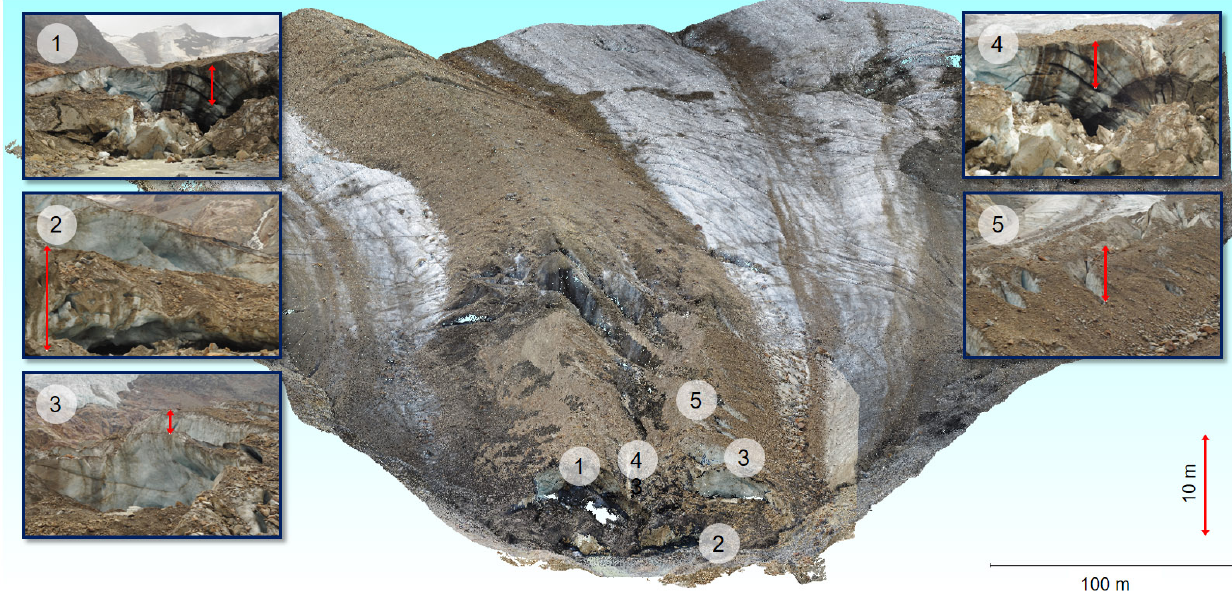
Figure 4. Location of different glacier features or hazard-prone areas on the tongue of Forni Glacier were the point cloud comparison was performed. The background image is the merged point cloud generated from the 2016 UAV and terrestrial photogrammetry